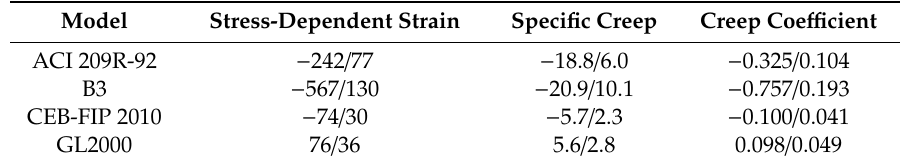
Table 7. The average and standard deviation of residual values by adjustment models predicted value minus experimental data value (shown as average / standard